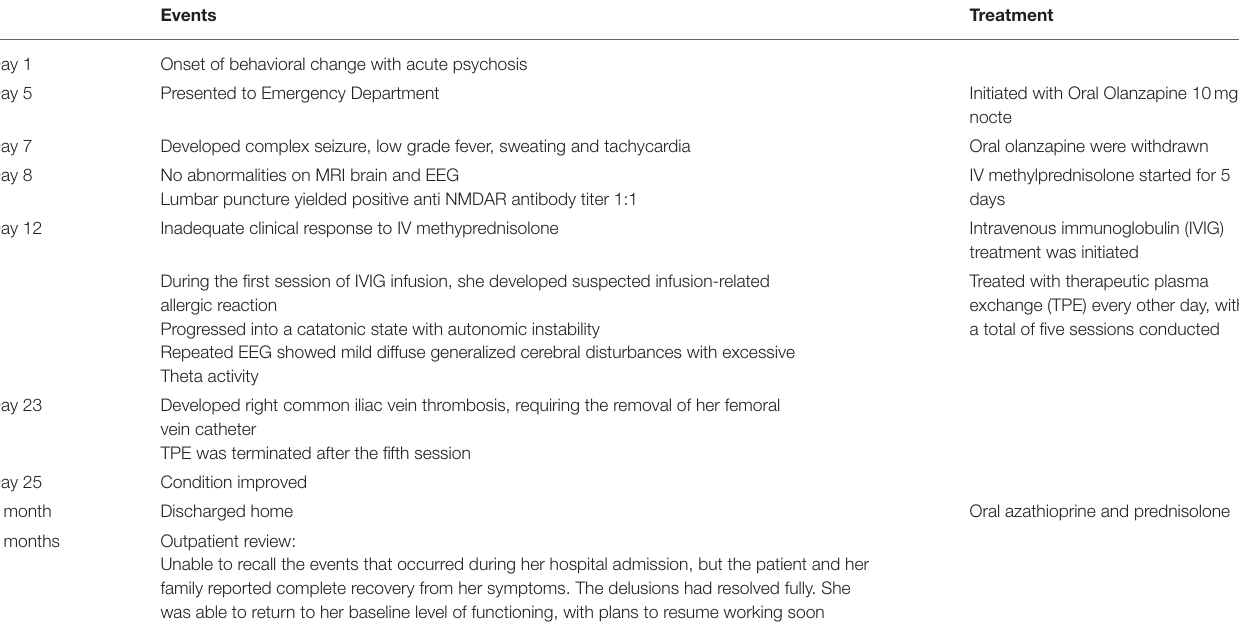
TABLE 1 | Timeline of events and